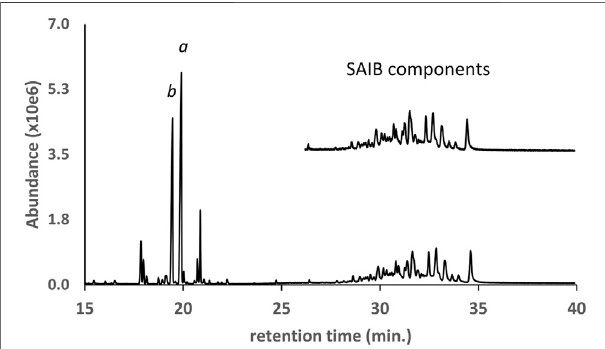
FIGURE 9 | GC-MS chromatogram for a vaping liquid (lower trace) in which a series of sucrose acetate isobutyrate (SAIB) compounds were identi fi ed(retentiontimerange28 – 35 min).TheSAIBstandardchromatogram (upper trace, expanded scale, offset) shows a similar distribution of components. The vaping liquid contained substantial levels of both d9THC and d8THC (peak labels a and b, respectively).